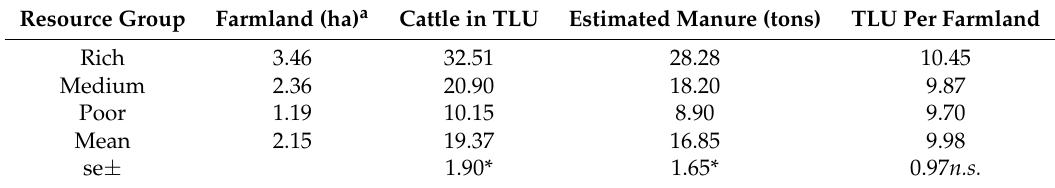
Table 2. Average TLU per cultivated land and theoretically estimated amount of manure per household resource group in Borana.